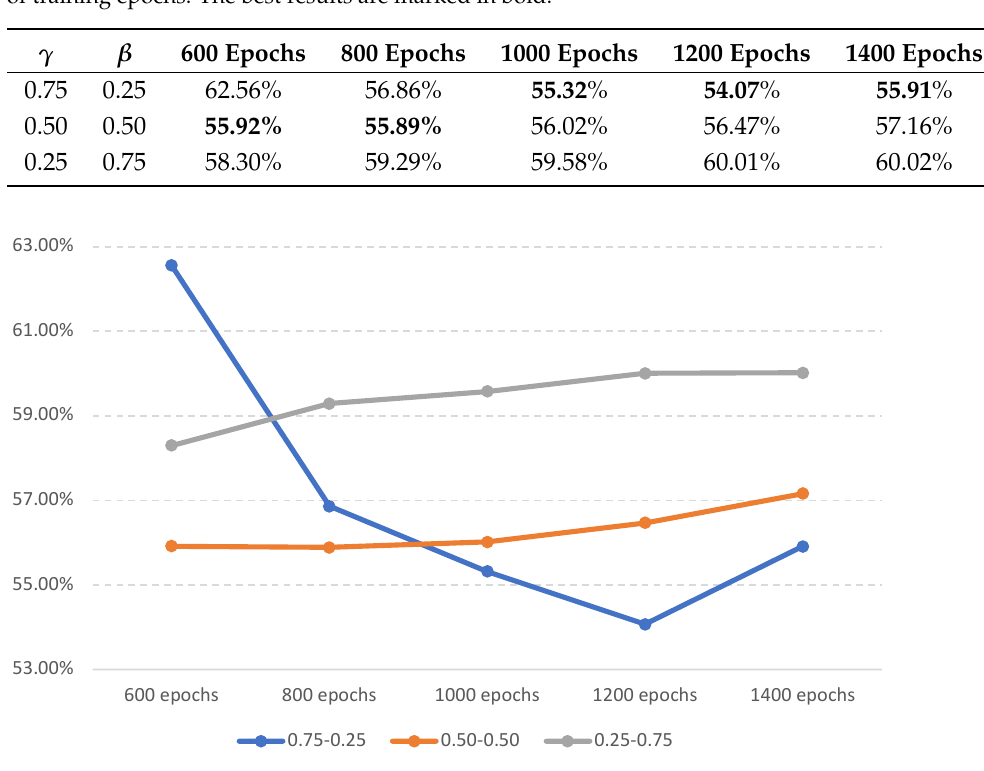
Figure 4. Evolution of DER% results as a function of the different parameter configurations.